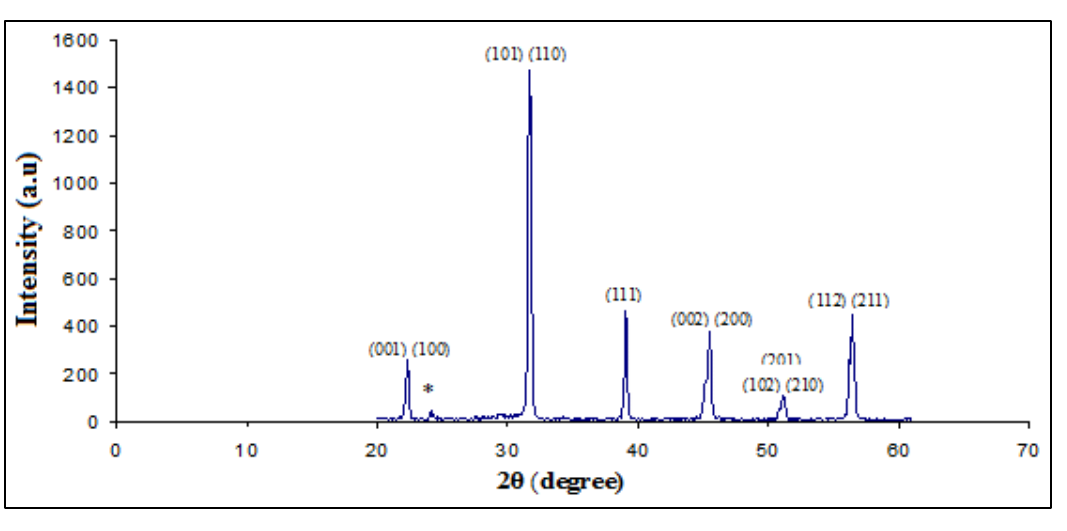
Figure 7: Barium Titanate XRD pattern at 1000 ° C. The symbol (*) refers to the peaks for the Titanium Dioxide this means that the reactions of Barium Titanate are not complete because of the presence of another peak which belongs to Titanium Dioxide (TiO 2 )